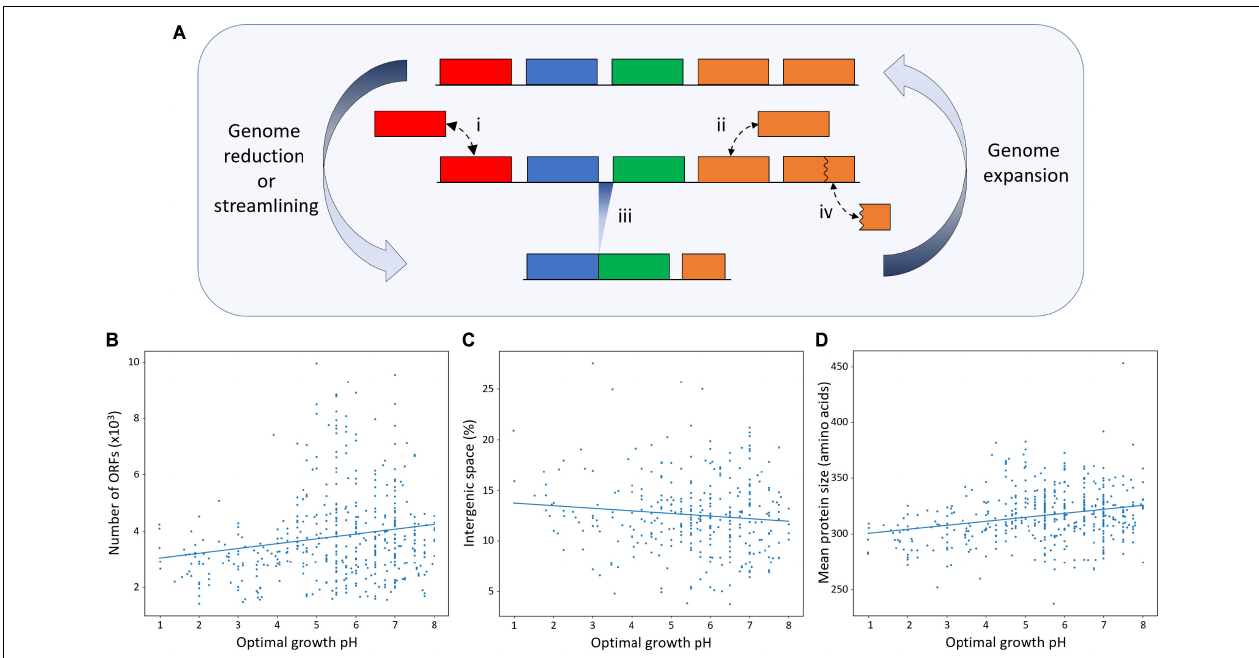
FIGURE 5 | Mechanisms involved in genome size changes. (A) Diagrammatic representation of the genetic mechanisms involved in genome size changes. Five genes of a hypothetical genome are shown, where the top, middle, and bottom rows represent an expanded genome, a transition genome, and a streamlined genome, respectively. The orange boxes indicate paralogous genes. The processes involved in genome size changes are shown, where (i) and (ii) represent gene loss/gain of single-copy genes or paralogous genes, respectively, (iii) shows the intergenic space reduction or expansion, which we refer to as genome compaction, and (iv) shows the gene size reduction or increase. (B) Number of genes (ORFs, open reading frames) across pH. Pearson’s correlation coefficient is 0.18, with p -value 1.25 × 10 − 4 . (C) Intergenic space vs. pH. Intergenic space is defined as the genome size minus the sum of the nucleotide length of all protein-coding genes as defined by the ORFs of a genome divided by genome size, in percentage. A stricter genome quality filter of 97% completeness and 2% contamination was used in this analysis to minimize mis-annotation errors due to fragmented genomes. In total, 394 genomes from 317 species passed the filter. Pearson’s correlation coefficient is − 0.11, with p -value 0.06. (D) Average protein length across pH. Pearson’s correlation coefficient is 0.25, with p -value 4.03 × 10 − 8